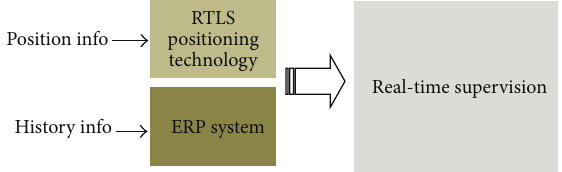
Figure 4: Vehicles battery supervision using RTLS and